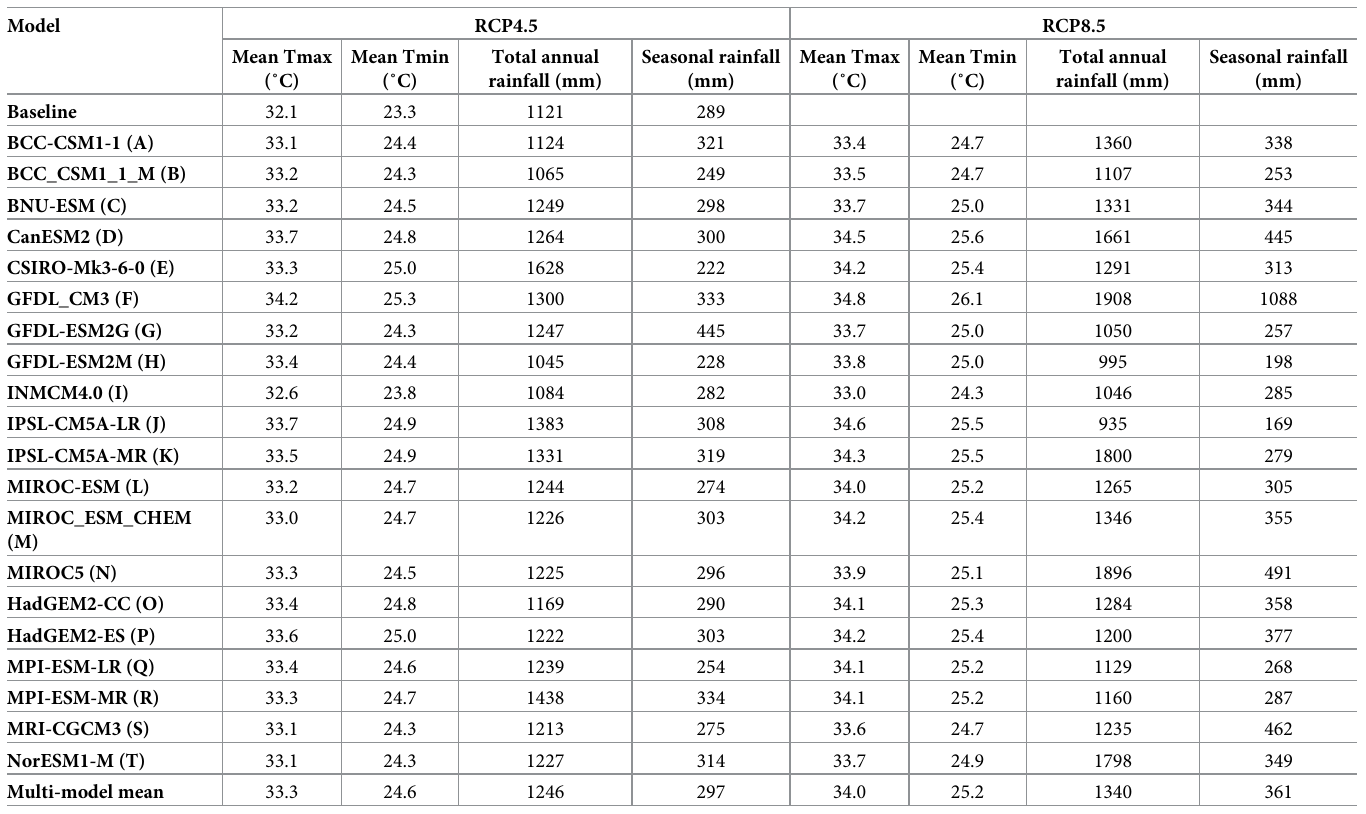
Table 4. The annual mean maximum and minimum temperatures, annual and growing seasonal (15th March– 15th June) rainfall for the baseline period (1980 − 2009) and in mid of the 21st century (2040 − 2069) for 20 general circulation models (downscaled using delta method) under the RCP4.5 and RCP8.5 scenarios in Bodagama, Sri